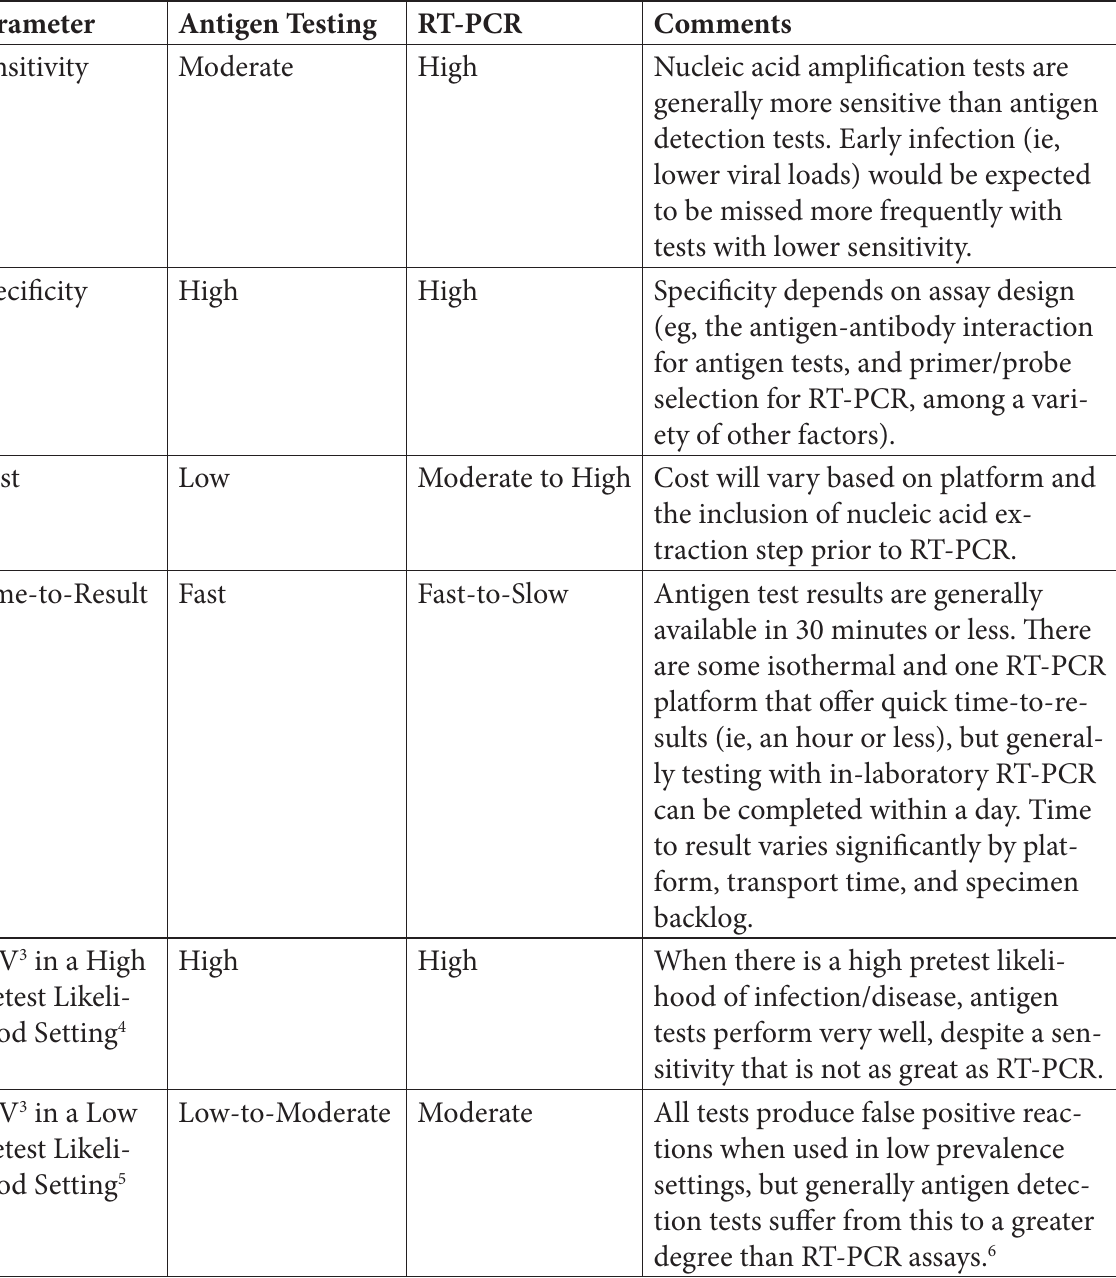
Table. The Benefits and Limitations of Antigen and RT-PCR Testing 1 for SARS-CoV-2